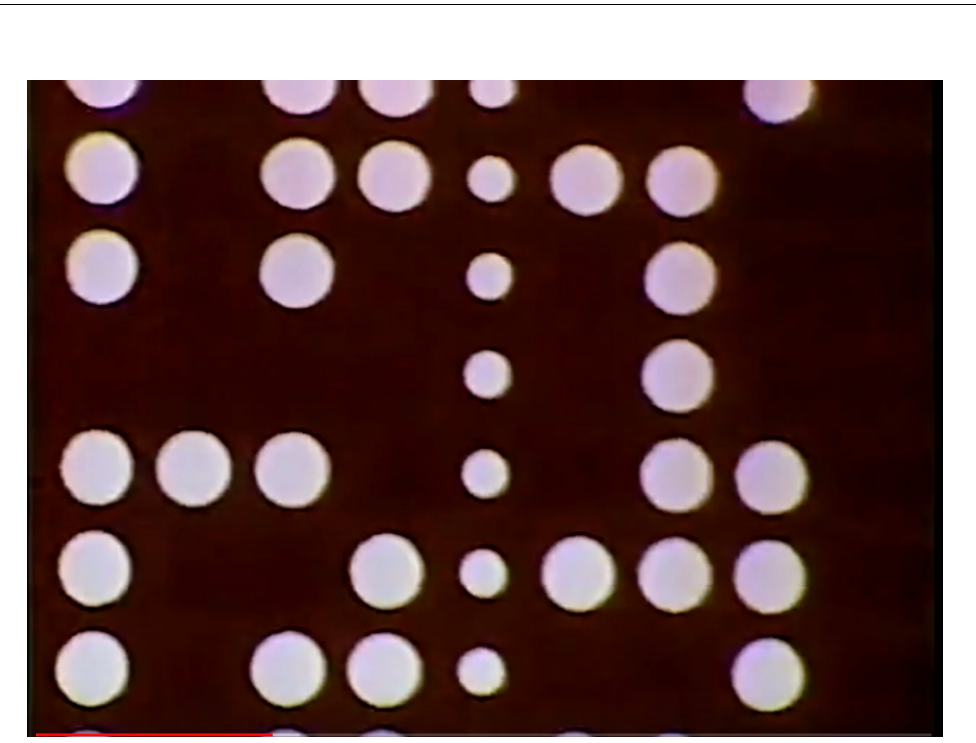
Figure 9: Close-up, punched-tape record of wave action, from Waves Across the Pacific